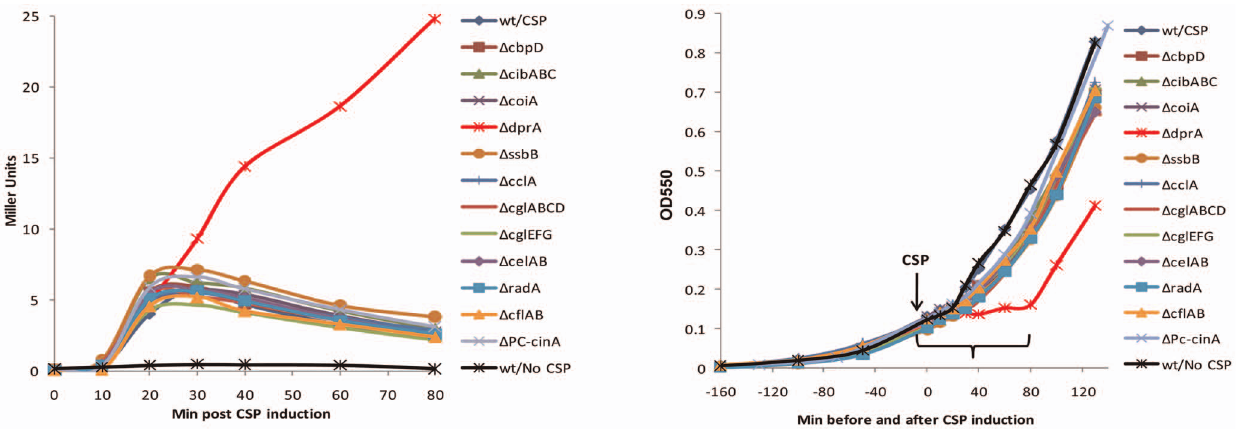
Figure 2. Survey of effect of late gene mutations on exit from the competent state. A. Late gene expression patterns were monitored in wild type and late gene mutants after CSP induction using a lacZ reporter inserted at the late gene ssbB . b -galactosidase activity (Miller units) was measured in culture samples harvested at indicated times after CSP induction. Each strain is indicated by its mutated competence gene (see Table 1). B. Growth patterns monitored as culture optical density at 550 nm before and after CSP treatment. Bracket indicates period of LacZ assay shown in panel A .